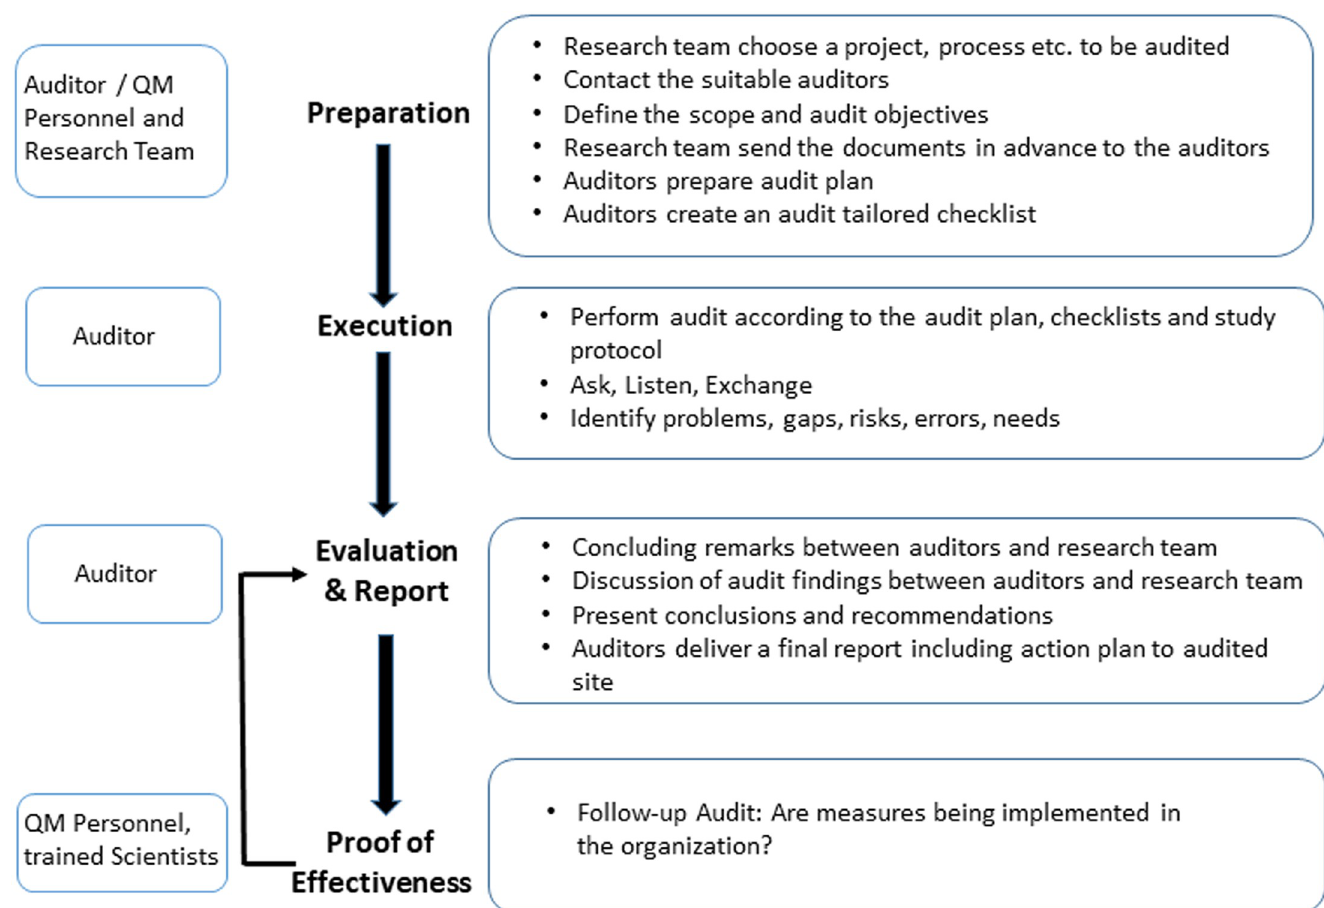
Fig 1. Audit workflow. This audit workflow describes the four steps performed during an audit in an academic preclinical research environment, but is universally applicable to all areas in which audits are performed. This audit workflow is a practical example of Deming’s PDCA (Plan-Do-Check-Act) cycle, which incorporates the process of continuous